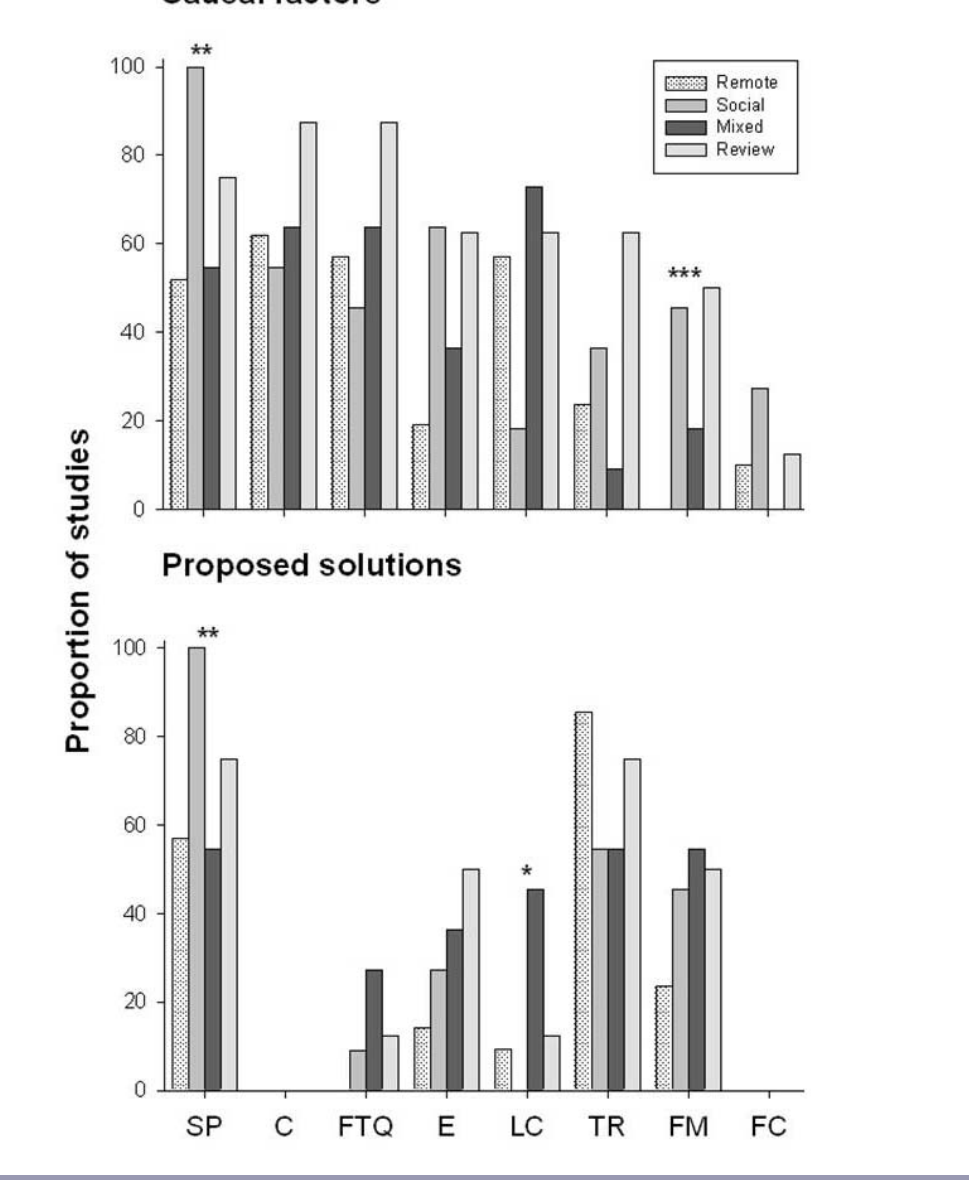
Fig. 2. Proportion of research approach and the categories (SP – socio-political; C – climatic; FTQ – forest type and quality; E – economic; LC – landscape context; TR – technological and research; FM – direct fire management; FC – fire characteristics) they identify as i) causal factors for fire, and ii) proposed management solutions. Significance values of results of analysis of variance to test for significant differences between research methods within category expressed as: *** = < 0.001; ** = < 0.01; * = <